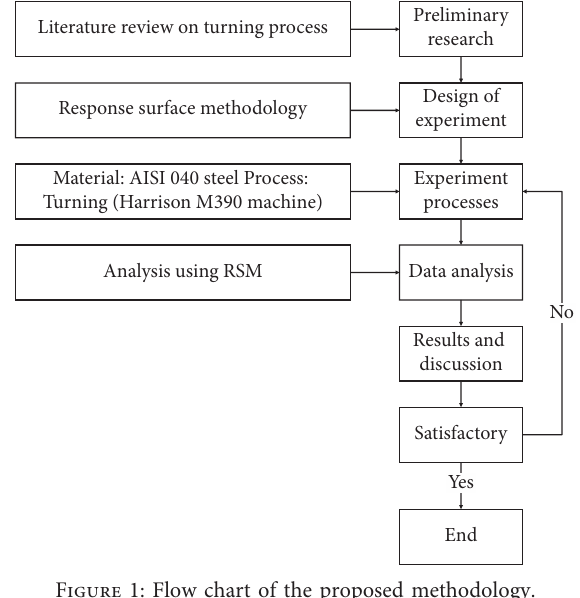
Figure 1: Flow chart of the proposed methodology.